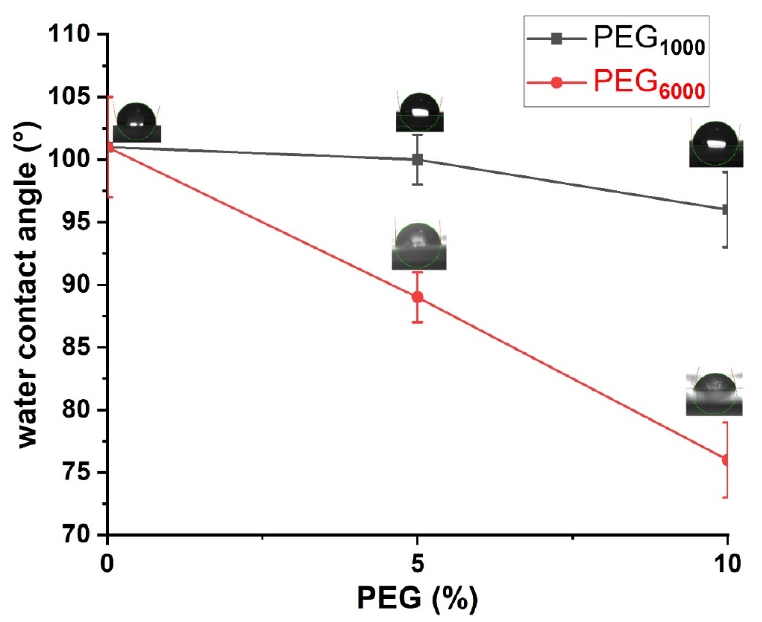
Figure 5. Water contact angle (WCA) change for copolymer series with PEG 1000 and PEG 6000 after 60 s.